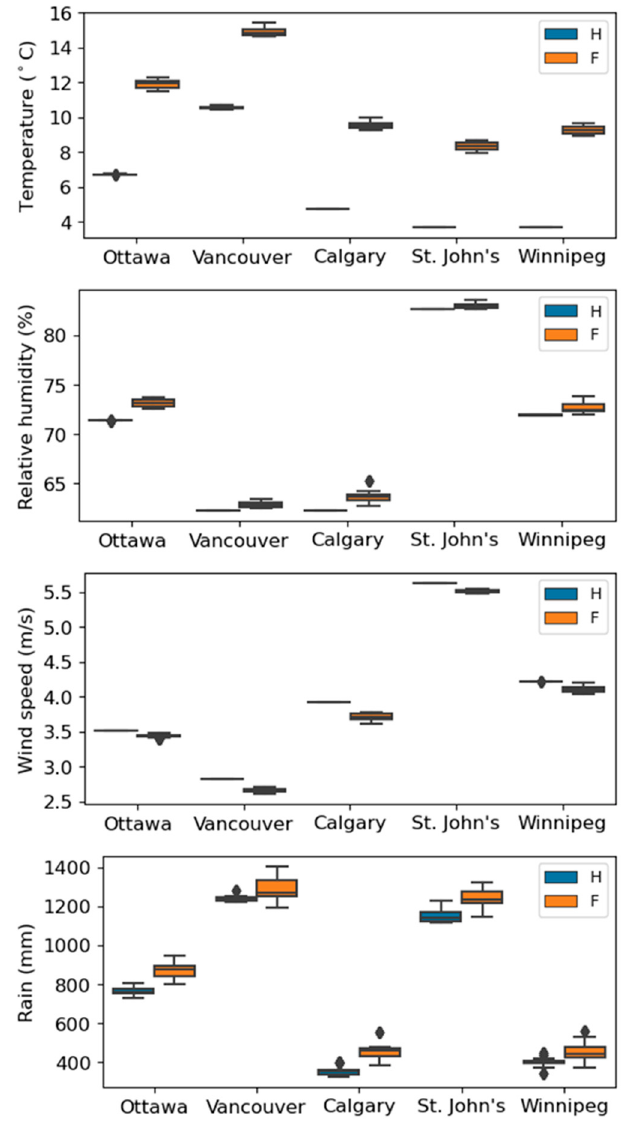
Figure 3. Boxplots of the annual average temperature, relative humidity and wind speed, and annual sum of horizontal rain for the all the runs of the historical (H) and future (F) time periods in the cities of Ottawa, Vancouver, Calgary, St. John’s and Winnipeg.